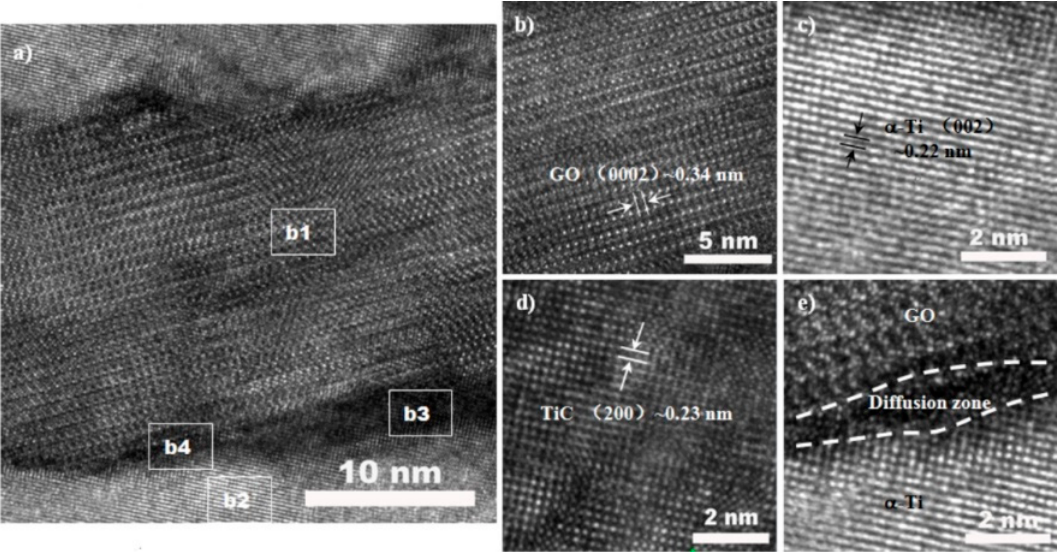
Figure 5. HRTEM images showing ( a ) detailed GO–TC4 interfacial structure, ( b ) the remaining GO located near the Ti matrix (the white square region b1 in ( a )), ( c ) the corresponding lattice spacing of α -Ti and its SAED at the marked region of b2, ( d ) in situ-formed TiC nanolayer (the white square region b3 in ( a )), and ( e ) the diffusion layer (the white square region b4 in ( a )).